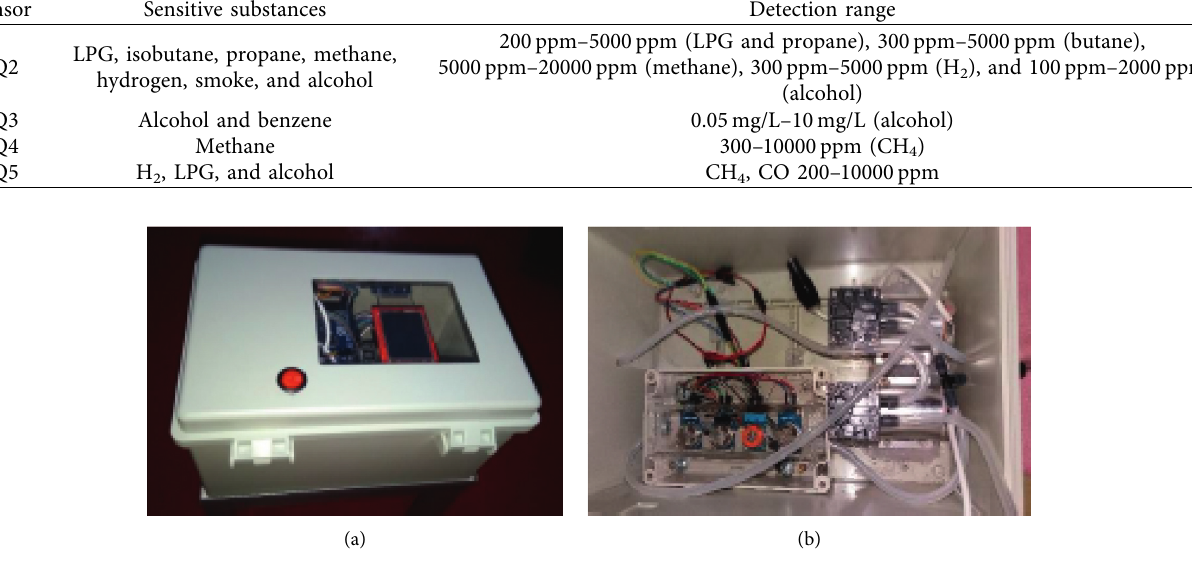
Figure 1: (a) E-nose system developed in this study. (b) The sensor chamber